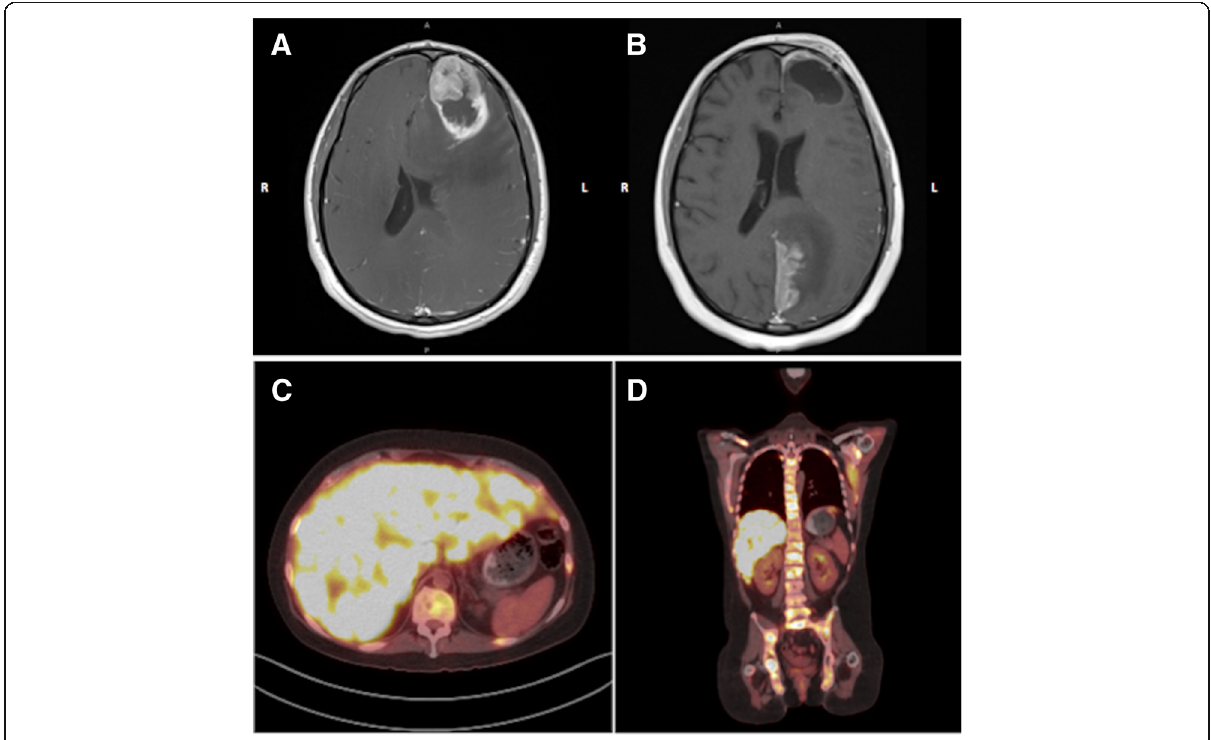
Fig. 1 Axial MRI brain post administration of gadolinium a on initial presentation with a large contrast enhancing lesion and a necrotic core in the left frontal lobe with mass effect. b Images 2 weeks after completion of radiation therapy showing an enhancing lesion involving the paramedian left parietal-occipital lobe extending to the superior surface of the left cerebellar tentorium. c axial and d coronal FDG PET scan with hypermetabolic lytic bony lesions throughout the axial and proximal appendicular skeleton as well as innumerable hyperdensities in the liver concerning for metastatic